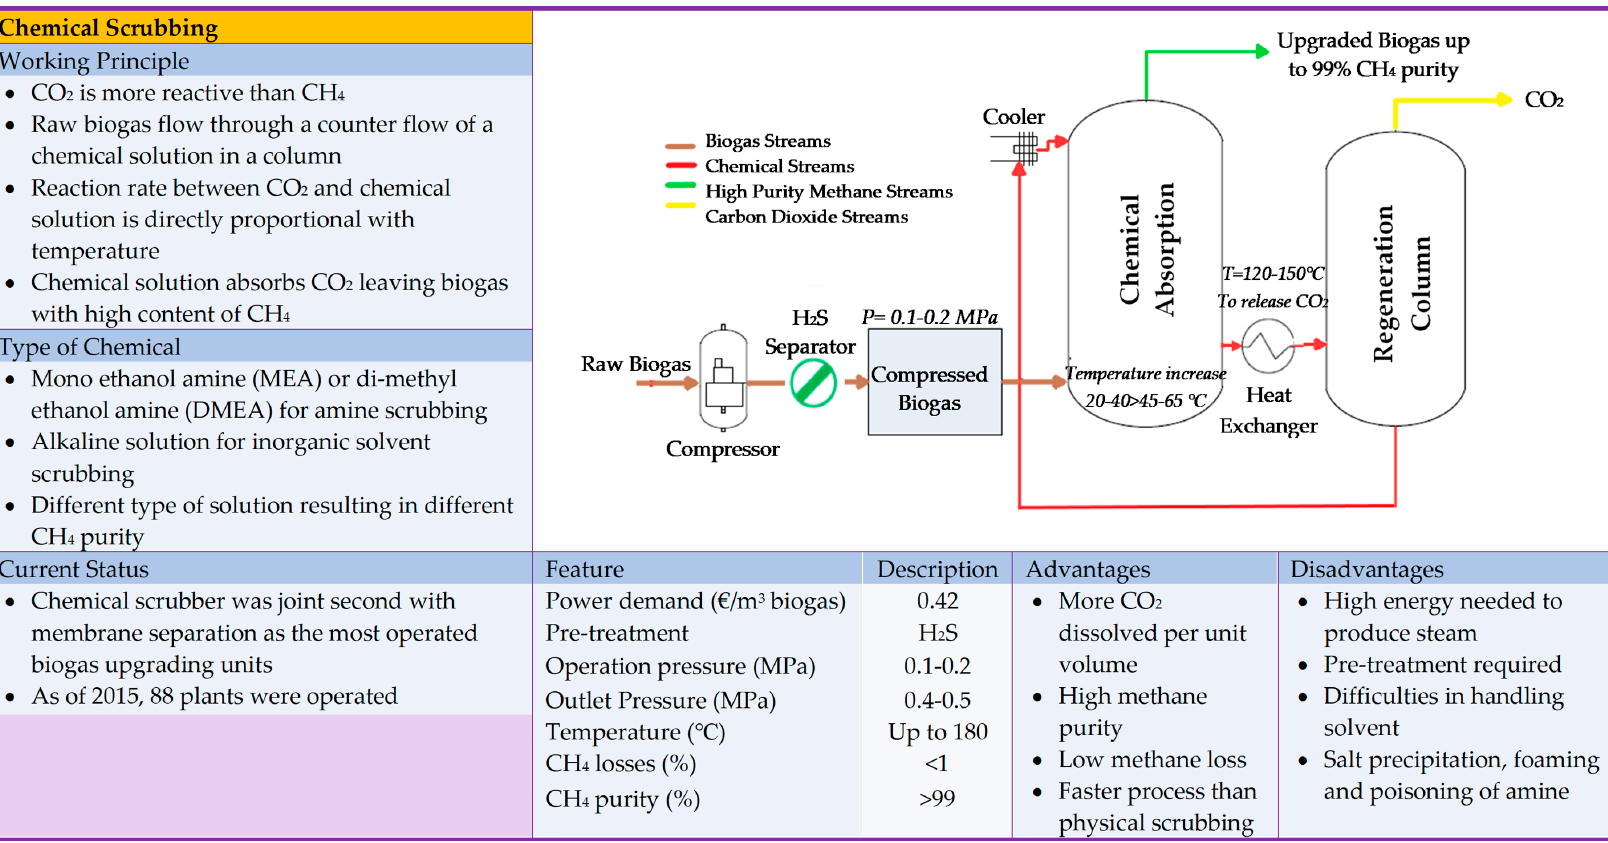
Figure 3. Summary of basic information on chemical scrubbing technology [15,19,20,25,27–32].